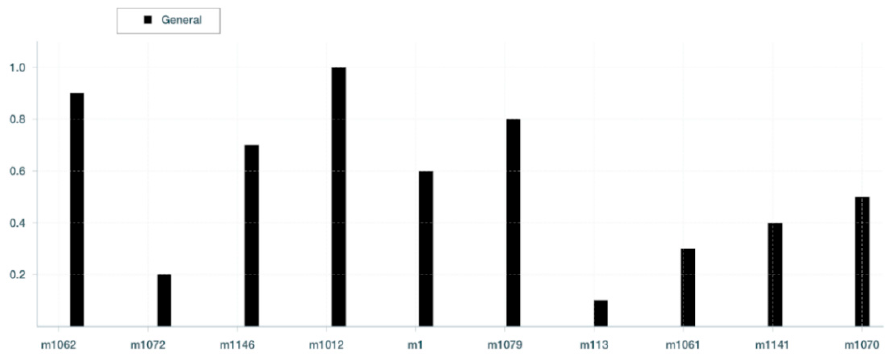
Figure 6. OpERA ranking for top 10 VM resources selected for Task 108145.